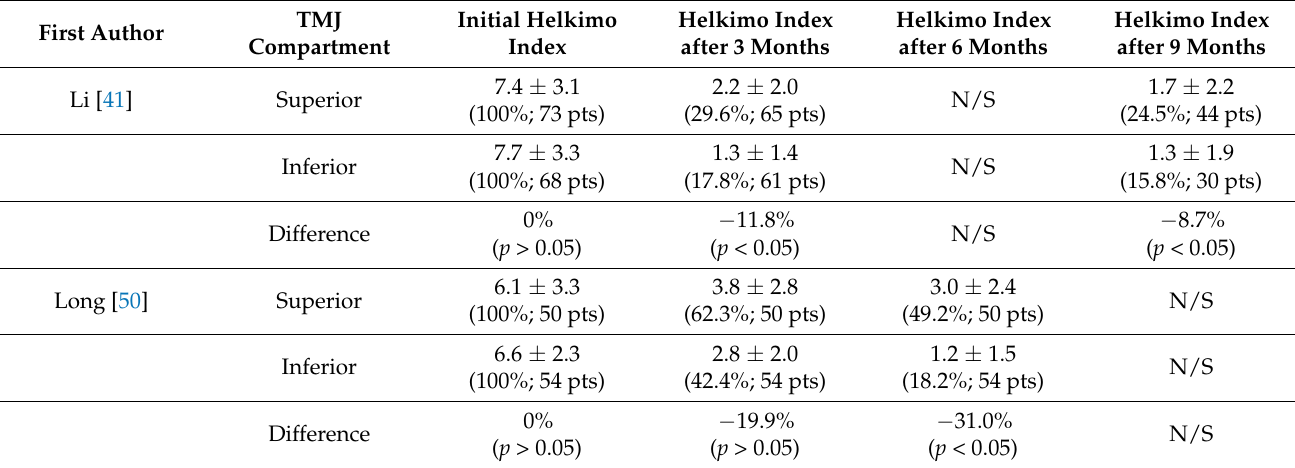
Table 5. Helkimo index.